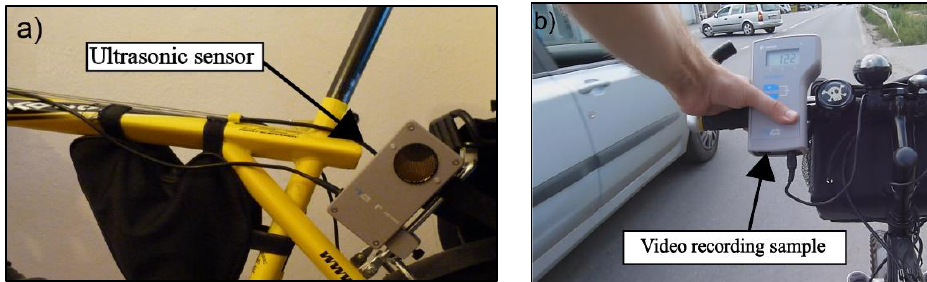
Figure 1. Presentation of the ultrasonic sensor used in the experiment ( a ) and an example of the b video recording ( b ). recording (